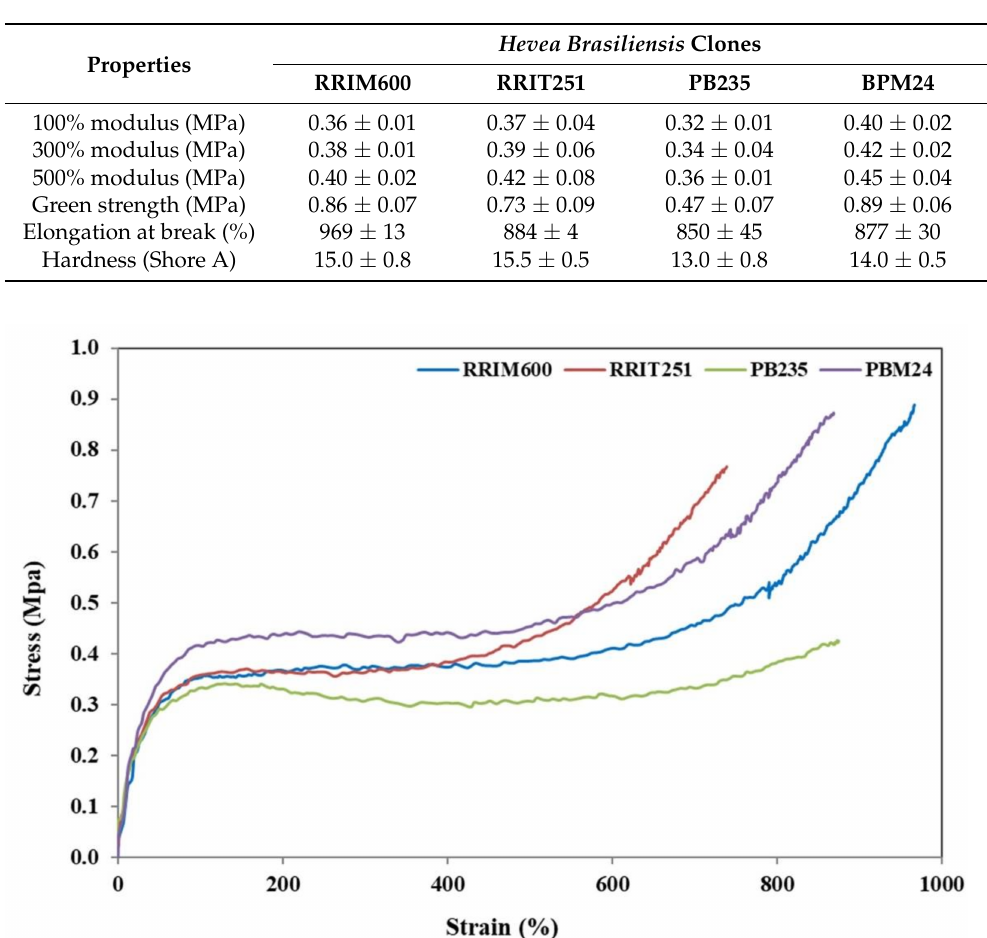
Figure 4. Stress-strain curves of NRs from the four Hevea brasiliensis